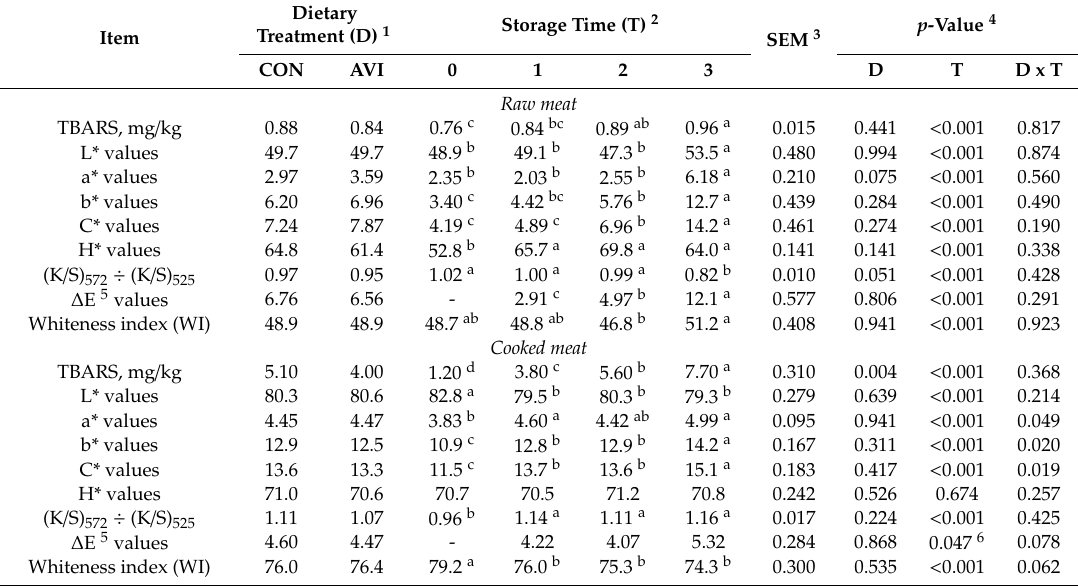
1 CON, basal diet; AVI, basal diet + 0.5% organic acids and essential oils. 2 Times 0, 1, 2, 3 correspond to: days 0, 4, 7, 11 (raw meat slices); days 0, 2, 4, 7 (cooked meat slices). 3 Standard error of the means (SEM). 4 p-Values associated with dietary treatment (D), time of storage (T) and their interaction (D x T). 5 Overall colour variation ( ∆ E) between each storage time and initial time. 6 No significant di ff erences were found for multiple comparisons using Tukey’s